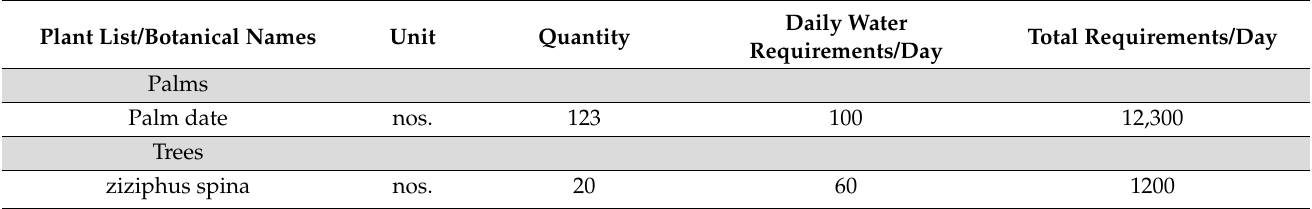
Table A8. Water consumption for each softscape item: Applying xeriscaping for WALKWAY